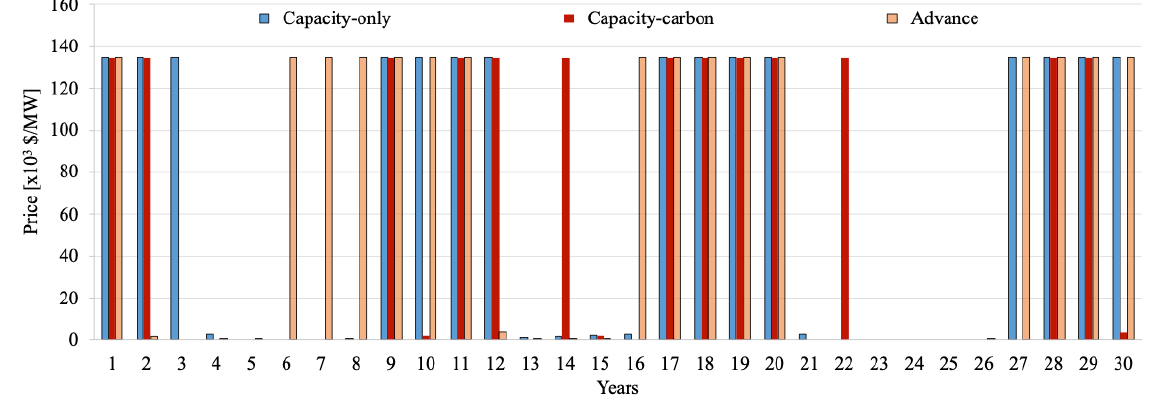
Figure 15. The change in capacity price.